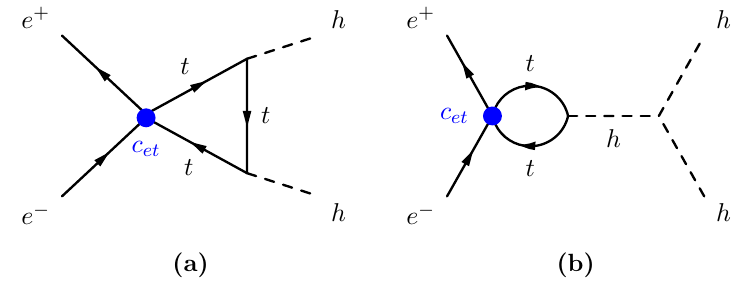
Figure 6. Loop level contributions e + e (cid:0) ! hh coming from eq.